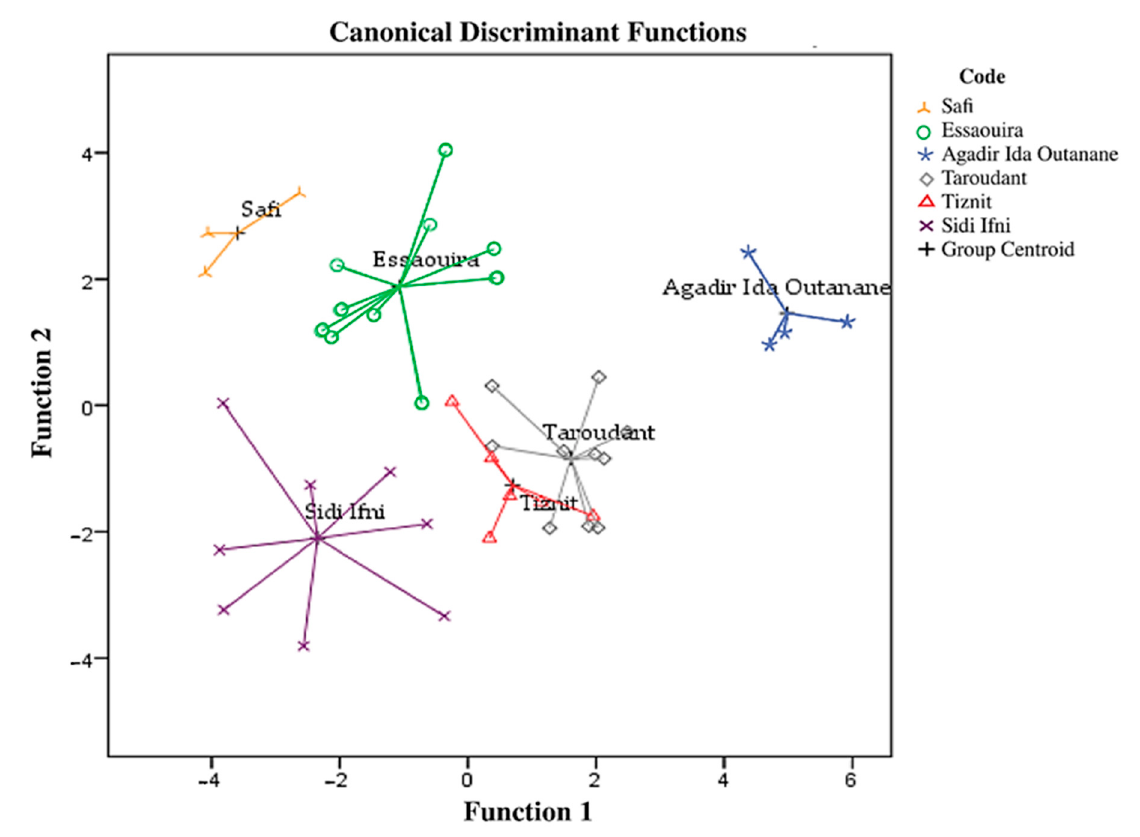
Figure 5. Linear discriminant analysis performed based on a combination of isotopic and fatty acid composition of Argan oil samples from six provinces. Table 3. Discriminant functions elaborated based on the combination of stable isotope ratios and fatty acid composition. Functions Wilks’ Lambda p -Value